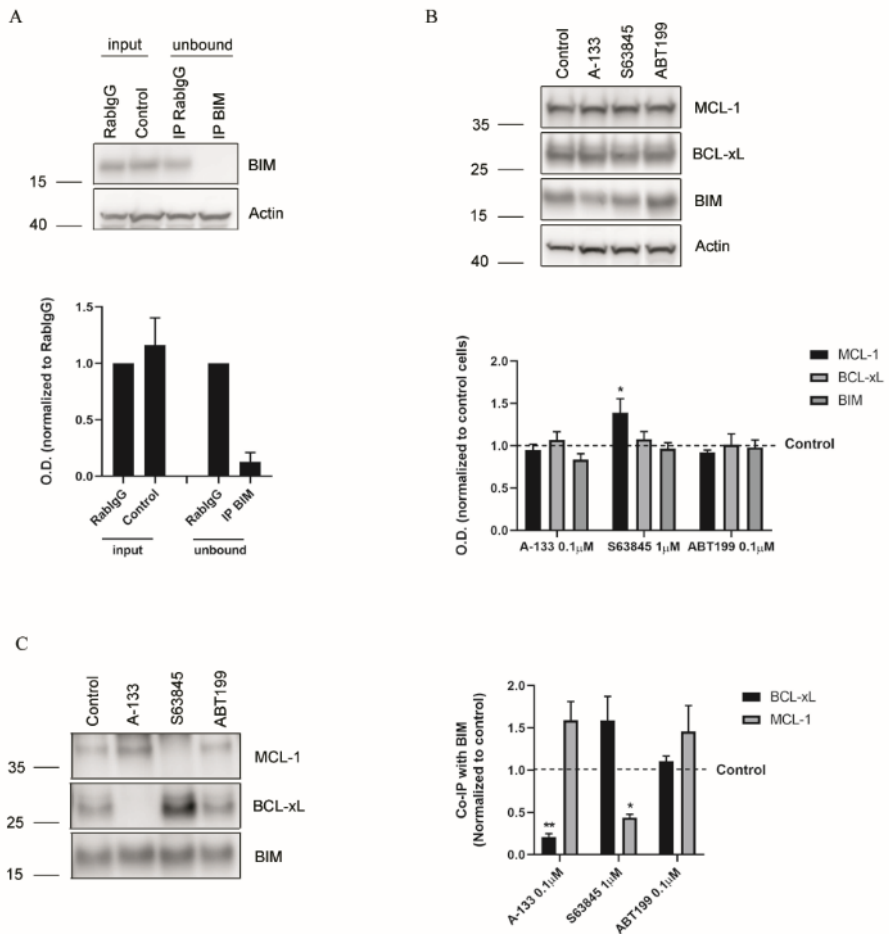
Figure 4. The acquired resistance mechanisms are controlled by the amount of anti-apoptotic protein bound to BIM. ( A ) Upper panel: Representative images of Western blot analysis of T47D cell lysates and unbound fractions after BIM immunoprecipitation. Lower panel: Optical density quantification of BIM normalized with actin levels and represented as fold increase compared to the control condition RabIgG. ( B ) Upper panel: Representative images of Western blot analysis of T47D cell lysates after 16 h treatment with the indicated drugs. Lower panel: Optical density quantification of each protein normalized to actin and represented as fold increase compared to control cells ( C ) Left panel: Representative images of Western blot analysis of BIM immunoprecipitation in T47D cells. Right panel: Quantification of the optical density of each protein and represented as binding ratio between BIM and MCL-1 or BCL-xL. Results expressed as fold increase represents the increase in optical density after treatments compared to control cells. Values indicate mean values ± SEM. ** p < 0.01, * p < 0.05 and all experiments were performed at least three times.